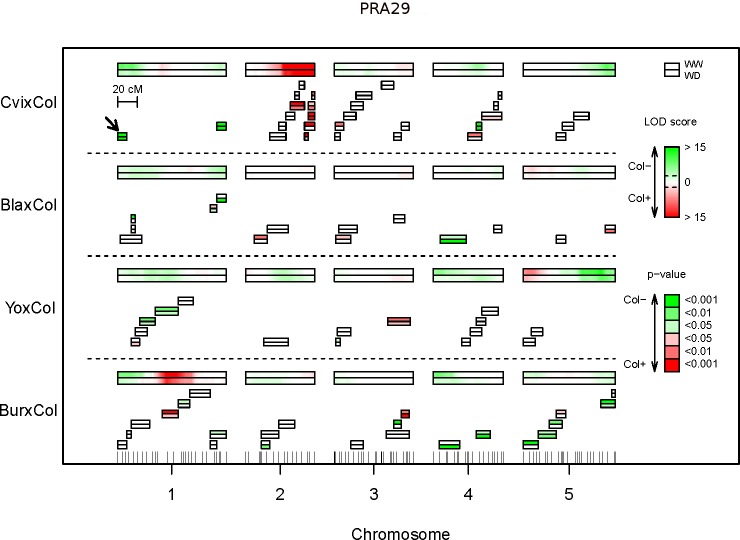
Near isogenic lines-based validation of QTLs for PRA29.QTL mapping results (same LOD score profiles as Fig 3) are shown as LOD score heatmaps (see color scale on the right) for each RIL set, across long twin boxes representing the 5 chromosomes (the upper frame is for WW, the lower frame is for WD conditions). Below each chromosome are series of short twin boxes representing individual HIFs segregating region, used to test phenotypes associated with specific regions (for each twin box the upper frame is for WW, the lower frame is for WD). The significance and the direction of the difference between Col-fixed HIF lines and alternate parental allele-fixed HIF lines are indicated by the p-value color scale as indicated. Details of each HIF used here are gathered in a deposited dataset [50]. An arrow indicates the HIF exploited further in the 'microStairs' approach. This figure shows results obtained for trait PRA29 only; other traits are in S6 Fig.